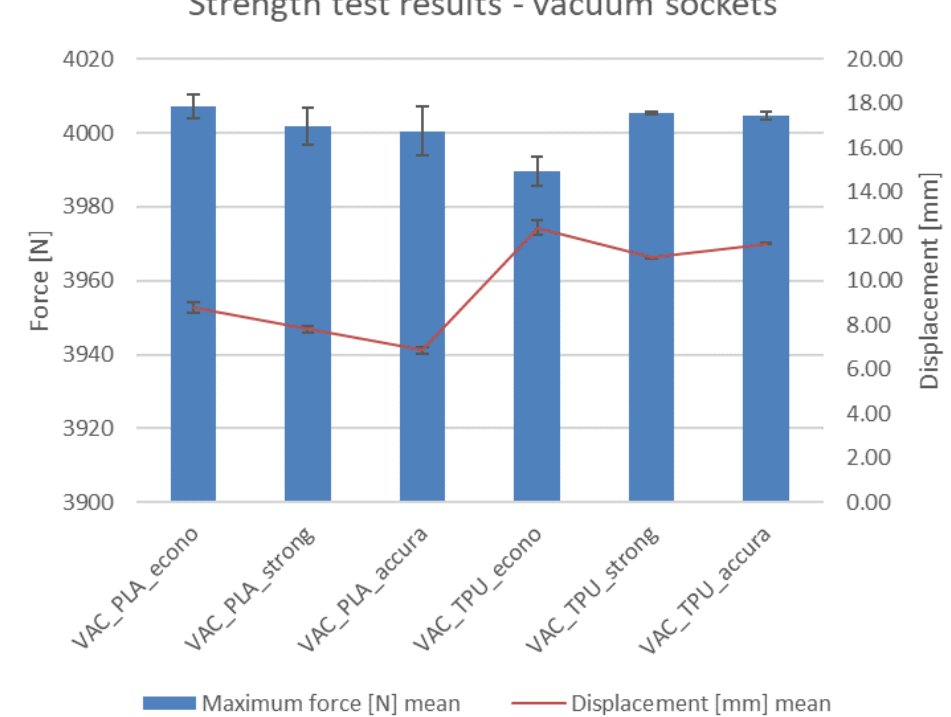
Figure 19. Strength test results for the vacuum sockets.